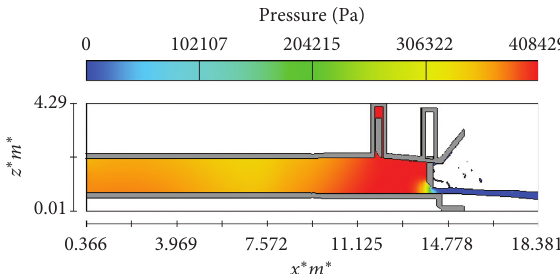
Figure 20: The pressure amount in the channel area leading to the gate and the branch in the state of 60% opening (100% valve opening).